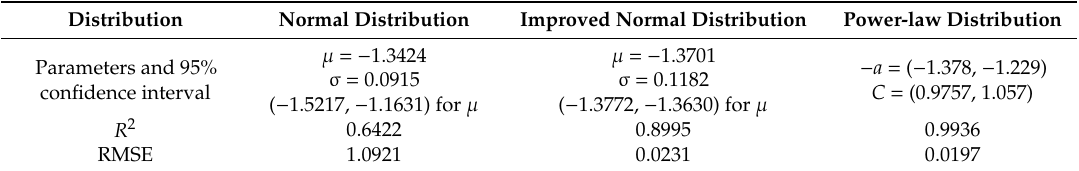
Table 5. Parameter estimations under di ff erent